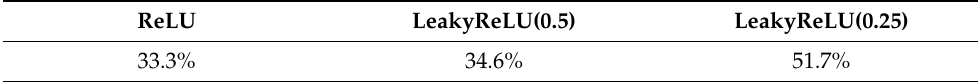
Table 1. The accuracy of three classes classification with different activation functions.